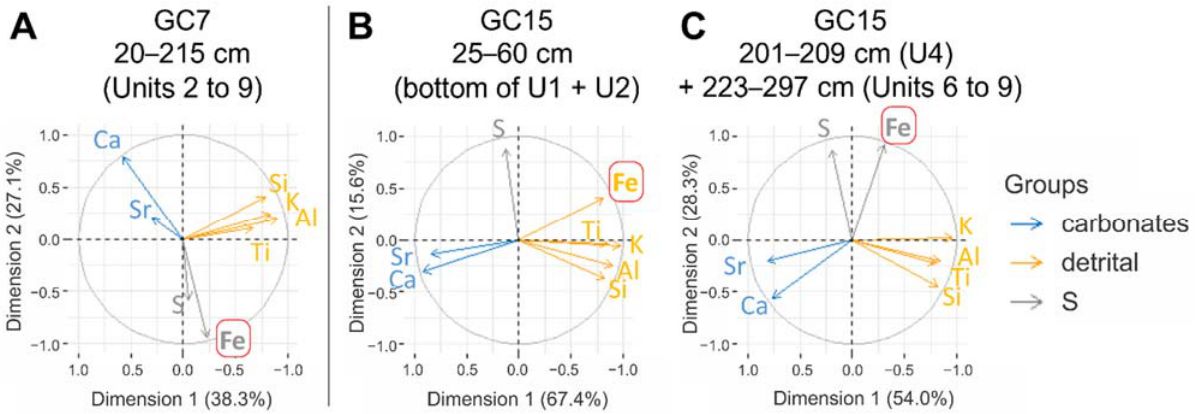
Figure 8. Principal component analyses (PCAs). In both cores, PCAs illustrate the anticorrelation between Fe and calcium (Ca) + strontium (Sr), interpreted as the carbonate cluster (blue). Moreover, Al, Si, K and Ti were strongly correlated with each other and considered as the detrital element cluster (yellow). PCA of ( A ) the GC7 core showing that Fe was correlated with S and not with detrital elements (65.4% of the variance explained by dimension 1 and 2); ( B ) the upper part of GC15 where Fe was situated closer to the detrital cluster than to S (83.0% of the variance); ( C ) the bottom part of GC15 where Fe was closer to S than to detrital elements (82.3% of the variance explained). U = Unit. The continuous semi ‐ quantitative Fe counts in the XRF core scanner (Figures 6F and 7F) were plotted together with ICP ‐ MS quantitative Fe concentrations (Figures 6G and 8G). It illustrates the absence of possible calibration between the two methods. Moreover, the variations in Fe/Ti measured with the XRF core scanner are displayed in Figures 6H and 7H. Reactive iron, i.e., the sum of all the extracted fractions represents, on average, 36 ± 4% of total iron in GC7 and 38 ± 6% in GC15. In GC15, reactive iron accounted for 32 to 55% of the total iron (Table A5). In both cores, Fe org was not abundant and remained rela ‐ tively constant (5 to 10% of reactive iron; Table A5). In GC7, the reactive iron speciation was homogeneous (Figure 6I), dominated by the Fe H fraction (87 ± 4% of reactive iron). The other fractions were less abundant. The pyrite fraction only corresponded to 6 ± 2% of reactive iron (Table A5). In contrast, GC15 showed an iron reduction with depth (Figure 7I). Indeed, the Fe pyr fraction gradually increased with depth from 20% up to 80% of reac ‐ tive iron at the expense of the Fe ox and Fe H fractions (Figure 7I). 4.3. Mineralogical Proxy: Framboidal Pyrites Pyrite is composed of iron and sulphur. Total Fe content, measured by ICP ‐ MS, var ‐ ied between 3.8 ± 0.2 and 5.2 ± 0.2 wt % for GC7 (Figure 6G) and between 2.1 ± 0.1 and 4.4 ± 0.2 wt % for GC15 (Figure 7G). Thus, total iron was, on average, more abundant in GC7 (4.5 ± 0.3 wt %) than in GC15 (3.1 ± 0.6 wt %). However, total iron could not be used di ‐ rectly as a proxy because it indicates neither the iron redox ‐ state nor the amount of pyrite. Sulphur, measured by ICP ‐ OES, was, on average, less abundant in GC7 (0.26 ± 0.20 wt %, Figure 6E) than in GC15 (1.21 ± 0.51 wt %, Figure 7E). In GC7 (Figure 6J), no framboidal pyrites were found in the samples observed with the SEM, which was consistent with the absence of pyrite detected by XRD and the low amount of Fe pyr extracted. The absence of pyrite was also noticed in the uppermost sam ‐ ples collected close to the water ‐ sediment interface in MC7 (Figure 6J).